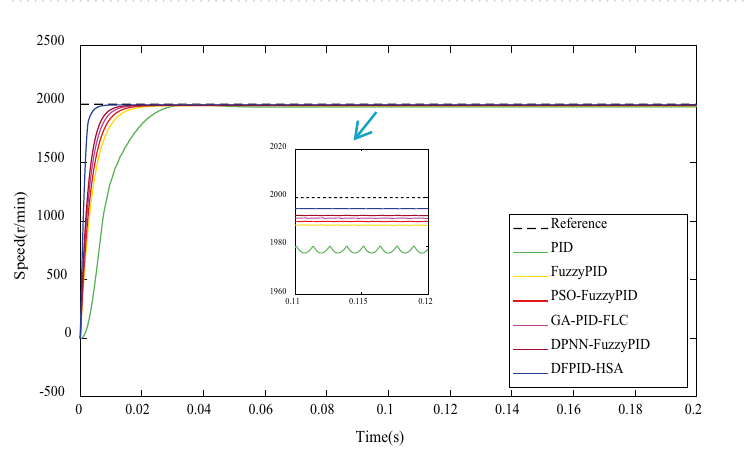
Table 8. The comparison of performance indicators under the fixed load condition.